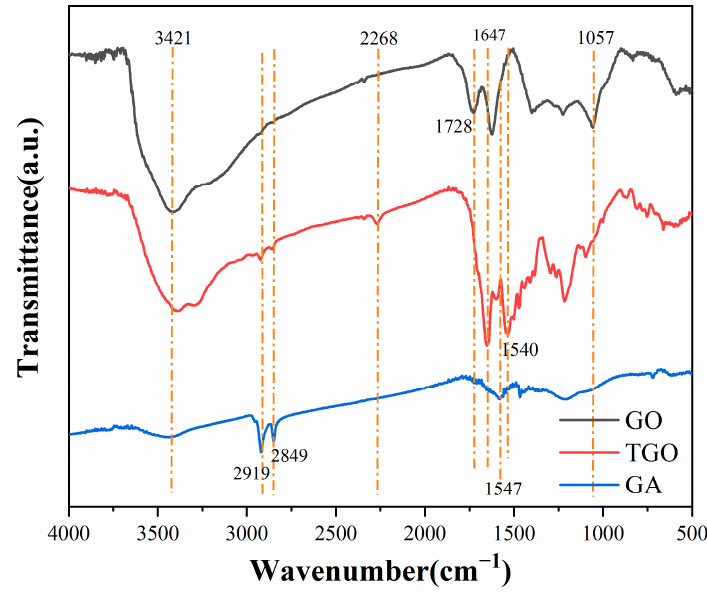
Figure 2. FTIR spectra of GO, TGO and GA .